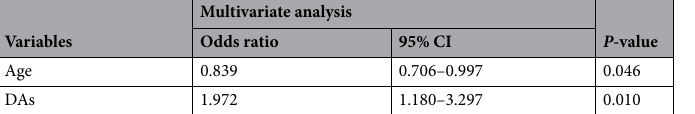
Table 4. Logistic analyses which investigate factors influencing vitreous hemorrhage. CI confidential interval, DAs disc areas. Excluded variables: sex, anti-VEGF, + /− of taking anticoaglant, subtype of AMD, duration of symptomes, CFT, the thickness of SMH, and the thickness of hemorrhagic